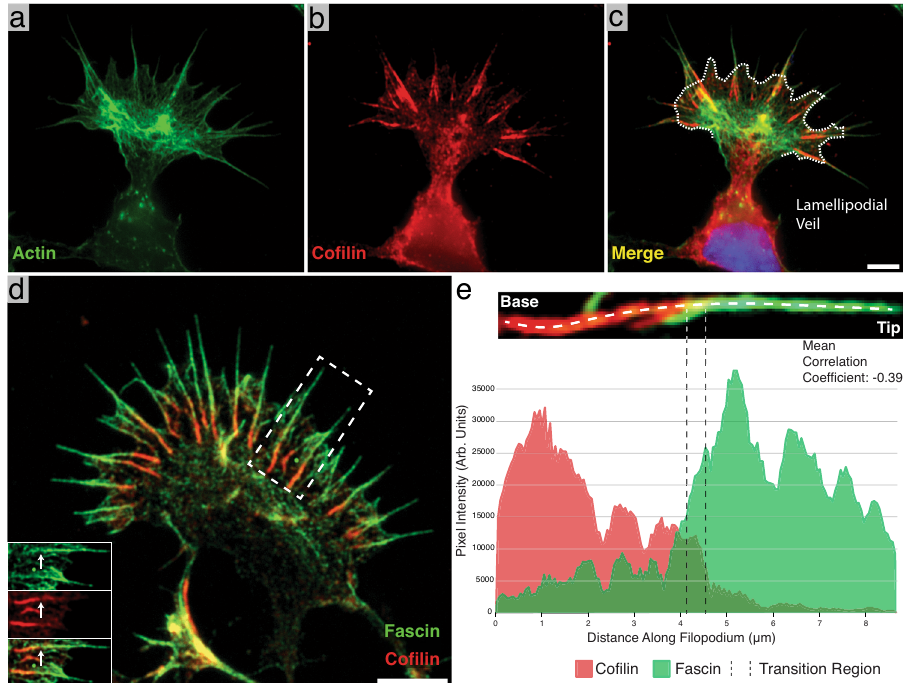
Fig. 1 Identi fi cation of co fi lin-rich regions at the base of neuronal growth cone fi lopodia. a – c Immuno fl uorescence images of phalloidin (Alexa Fluor 488) alone ( a ), co fi lin (Alexa Fluor 594) alone ( b ), and a merge of the two ( c ). Most of the co fi lin signal emanates from linear aggregates near the base of fi lopodia. The white dashed line in c marks the position of the lamellipodial veil. d Merged immuno fl uorescence image of a growth cone with fascin (Alexa Fluor 488-green) and co fi lin (Alexa Fluor 594-red) labeled, showing co fi lin-rich regions at the base of fi lopodia as in c . Bottom-left inset: Split view of the boxed-out region. The white arrow points to the same location in each image and shows the point at which the fascin signal drops off and the co fi lin signal intensi fi es. e Representative line scan intensity pro fi le of a single fi lopodium showing the distribution of fascin and co fi lin. The image above the graph shows a close-up view of the measured fi lopodium and the location where the line pro fi le was drawn. The transition region is marked by two dashed lines. The images in a – c are representative images, but two independent experiments showed similar localization of co fi lin and actin. d is a representative image from one of three independent experiments. Scale bars: ( c ) 5 µ m (this also corresponds to a and b ), d 5 µ m. Source data are provided as a Source Data fi